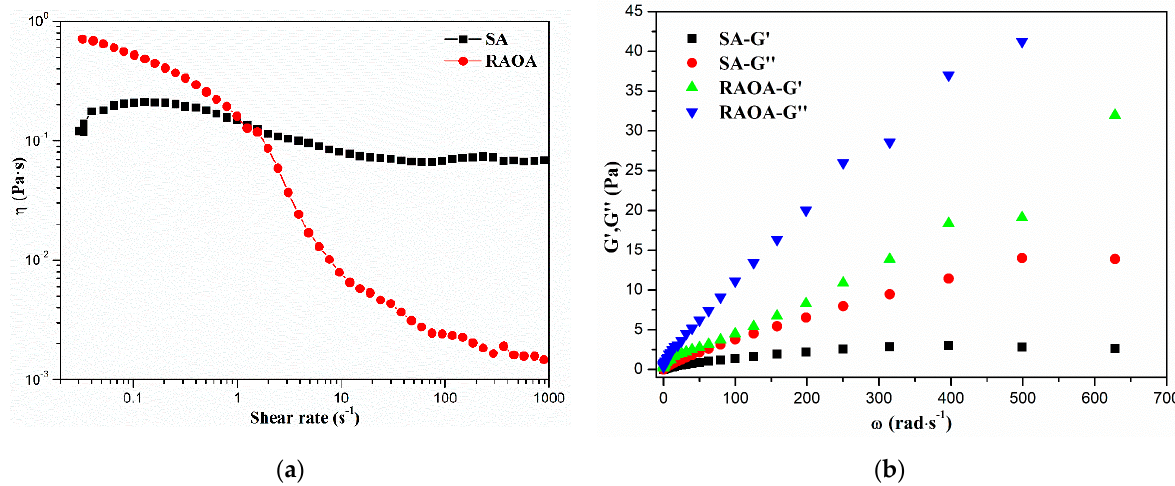
Figure 6. ( a ) The viscosity of the SA and RAOA aqueous solutions as a function of the shear rate at 30 °C; ( b ) Storage (G’) and loss (G’’) moduli of SA and RAOA aqueous solutions as functions of angular frequency ( ω ). The concentrations of SA and RAOA aqueous solutions were fixed, respectively, at 1 % ( w / v ).